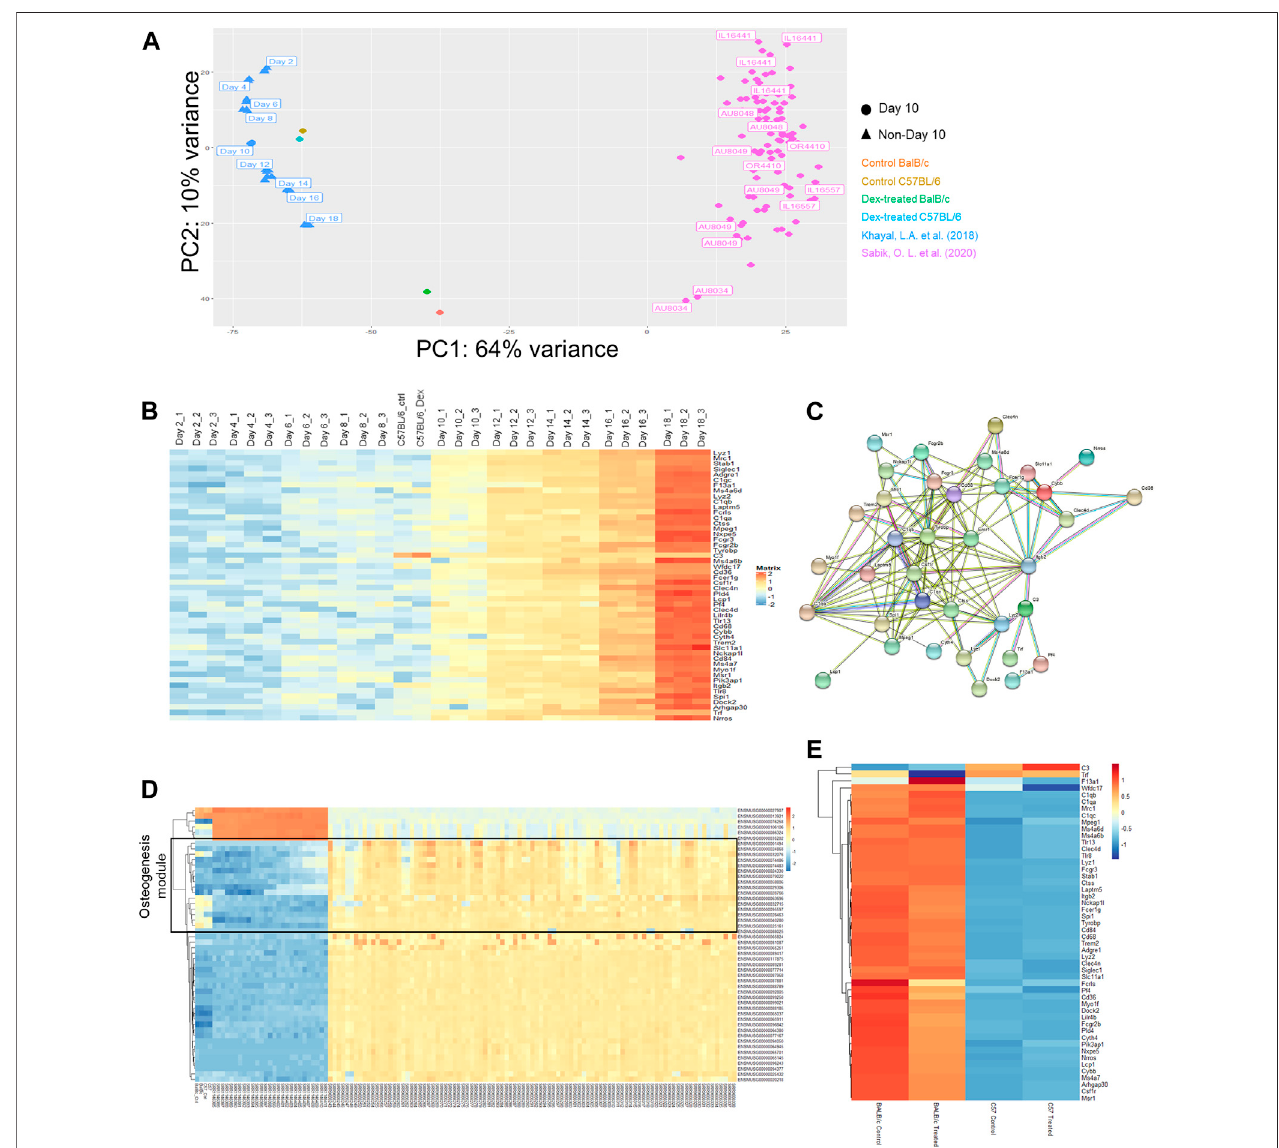
FIGURE 3 | Multiple comparison of transcriptomic pro fi les. (A) Principal component analysis (PCA) plot for expression pro fi les of Day 10 ex vivo mineralizing osteoblasts from a collection of CC mice lines adapted from Khayal et al. (blue), C57/BL6 (brown/cyan) and BALB/c (red/green) mice with or without prolonged administration of Dex and differentiating Col3.1 + osteogenic stromal progenitors along osteogenic differentiation (Day 2 to Day 18) adapted from Sabik et al. (pink). (B) Expression changes in the top 50 genes contributing to the variance along PC2 listed out from top tobottom from the PCA plot. NB. Day 10 mineralizing C57/BL6 osteoblasts shared similar expression pro fi le with mineralizing stromal progenitors upon Day 10 of their differentiation. (C) Protein-protein interaction network of co- expressed genes along PC2. (D) Expression changes in the top 50 genes contributing to the variance along PC1. NB. The top 50 genes clustered into the WGCNA module from Sabik et al. found with characteristic eigengene de fi ned by osteogenic potential (denoted in black). (E) Expression pro fi le of all genes in the protein-protein interaction network along PC2 in both BALB/c and C57/BL6 mice with and without prolonged administration of Dex.